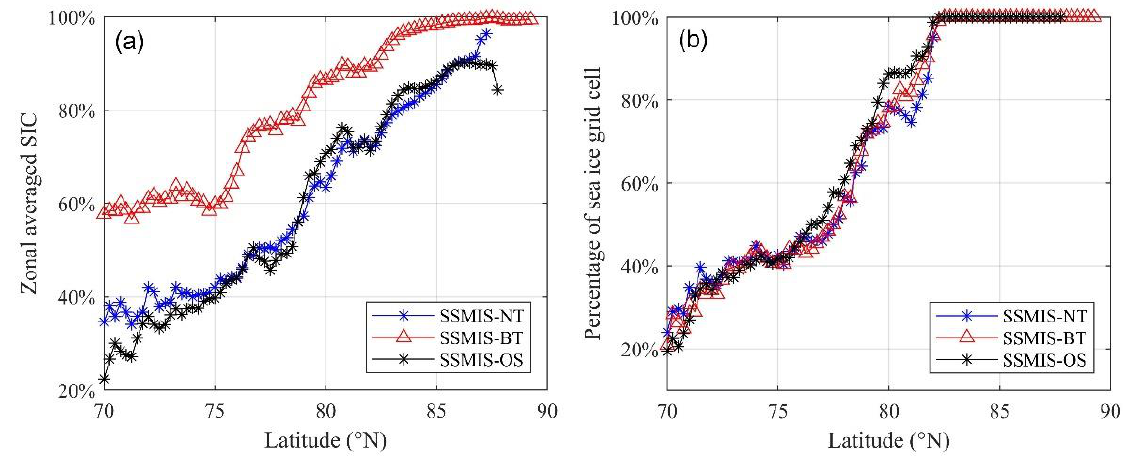
Figure 4. ( a ) The zonally averaged SIC and ( b ) the percentage of sea ice grid cells on 25 July 2012 for SSMIS-NT, SSMIS-BT, and SSMIS-OS.